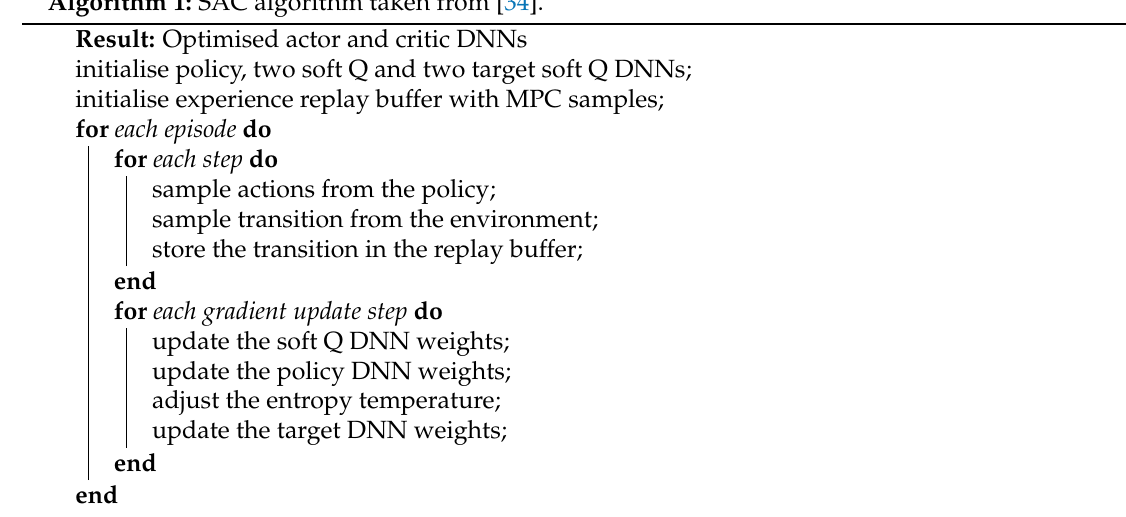
Algorithm 1: SAC algorithm taken from